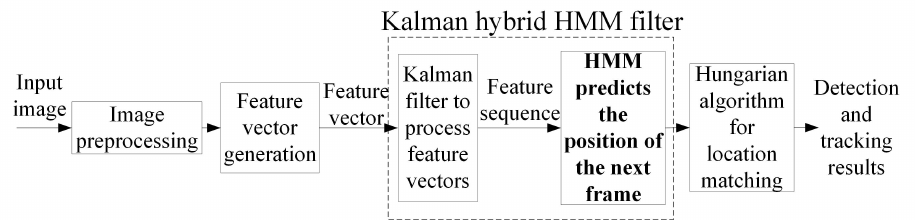
Fig. 3. Schematic diagram of railway tracks foreign object detection and